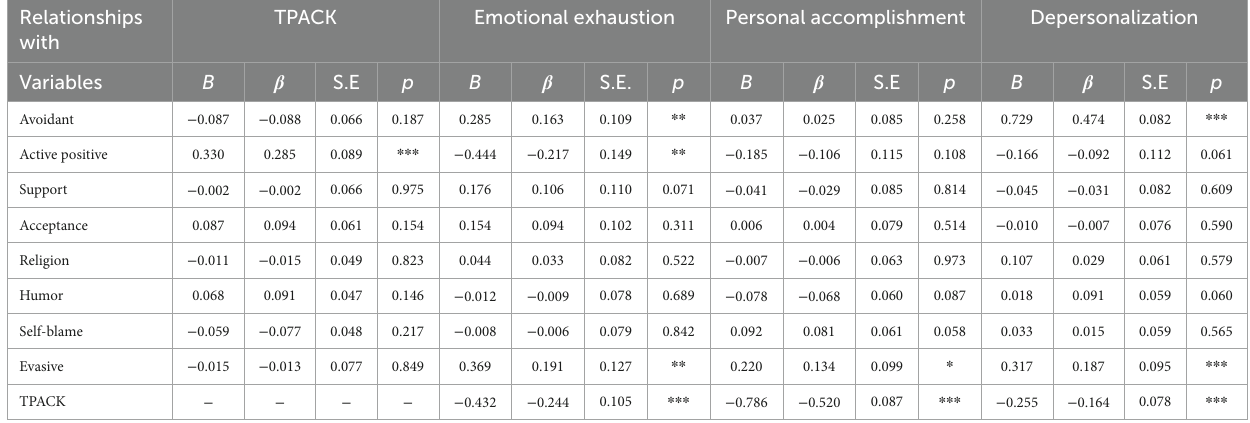
TABLE 5 Regression coefficients and standard errors for the pathways of the model. Relationships